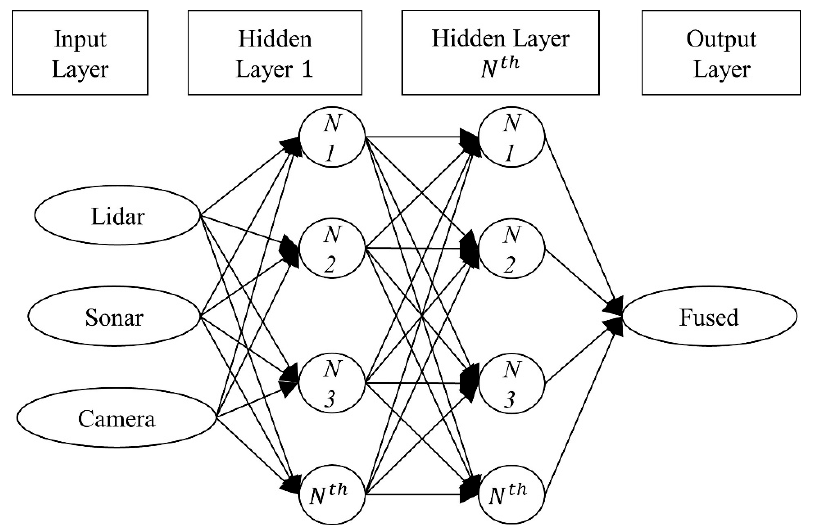
Figure 3. Basic structure of the DFFNN used where each input corresponds to the distance data of each sensor per degree.